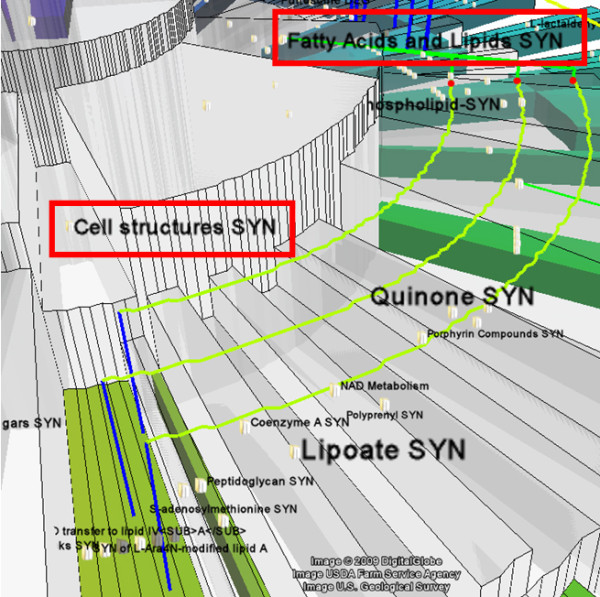
Zoom in view of pathway ontology. When zoom in, the labels of categories are shown, e.g. three pathways under cell structures biosynthesis also belongs to fatty acids and lipids biosynthesis.